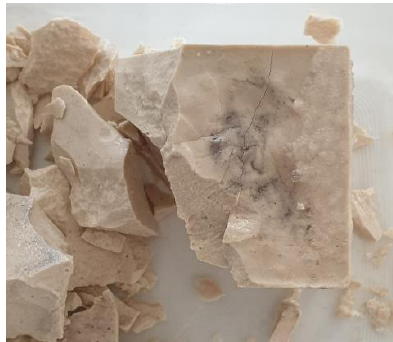
Figure 9. Photo showing the structural deterioration of the MW/MK 0.3 AAM after subjection to 15 freeze–thaw cycles.